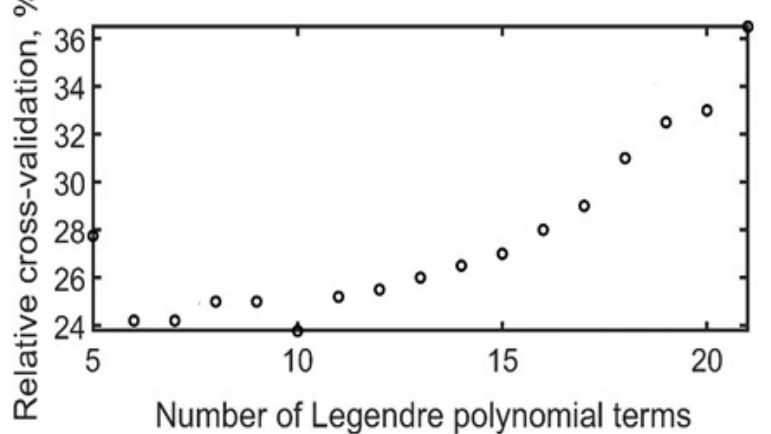
Figure 2. Cross-validation value vs a number of Legendre polynomial terms. This metamodel consists of 10 items, giving a minimal cross-validation error—23.77.